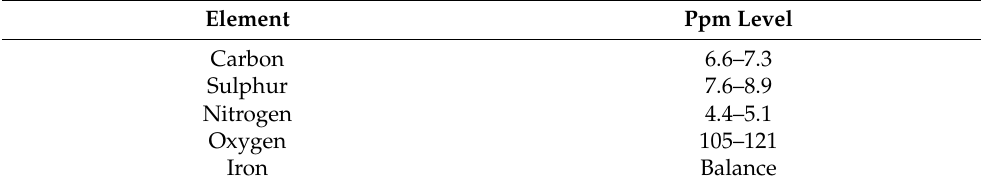
Table 2. Chemical composition of